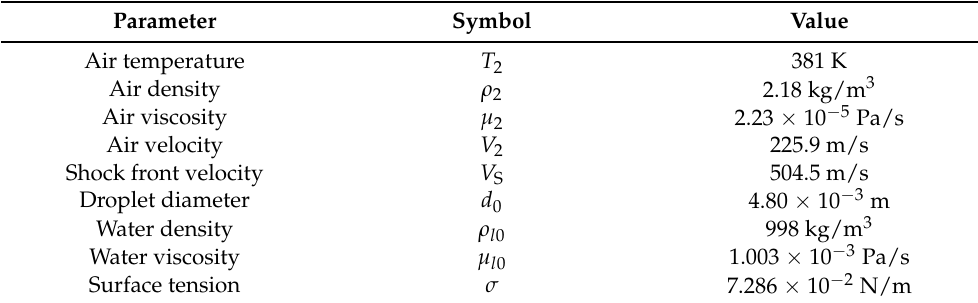
Table 2. Post-shock air flow and water body